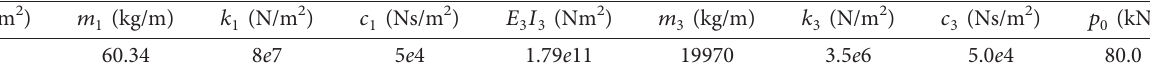
Figure 21: Track-tunnel-ground analytical model. Table 8: Parameters of the track-tunnel-ground model.